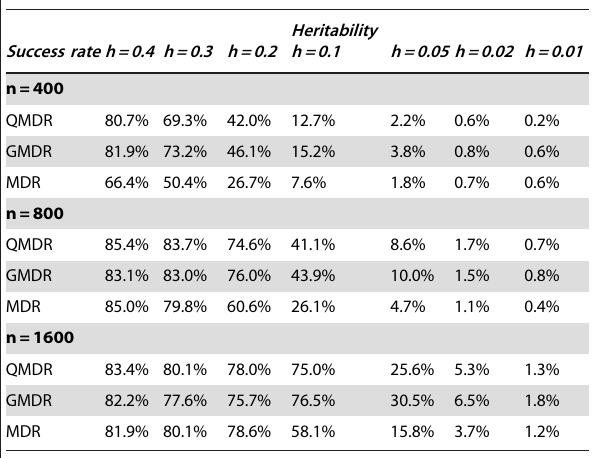
Table 1. Estimated type I error using the 95th quantile of the testing scores from datasets with 400 samples.